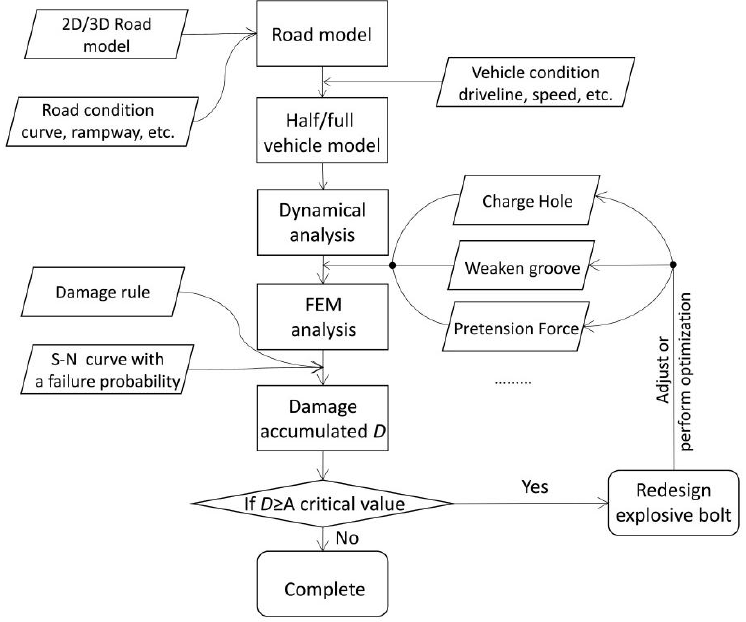
Figure 14. The diagram of fatigue assessment and redesign procedure.